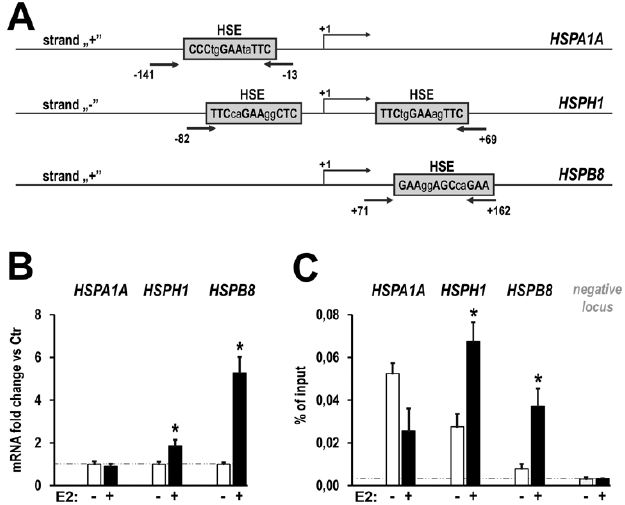
Figure 4. E2-induced HSF1 is transcriptionally active. ( A ) The architecture of promoter regions of three selected HSP genes: location of the heat shock elements (HSEs) and regions amplified in ChIP-qPCR analysis (arrows) are marked. ( B ) qPCR analysis of mRNA levels of selected HSP genes in response to E2 (10 nM, four hours). ( C ) qPCR analysis of E2-induced (10nM, one hour) HSF1 binding to the known HSE sequences in promoter regions of selected genes and to the control region (negative locus). Asterisks indicate the statistical significance of differences ( p < 0.05) between control and test samples.